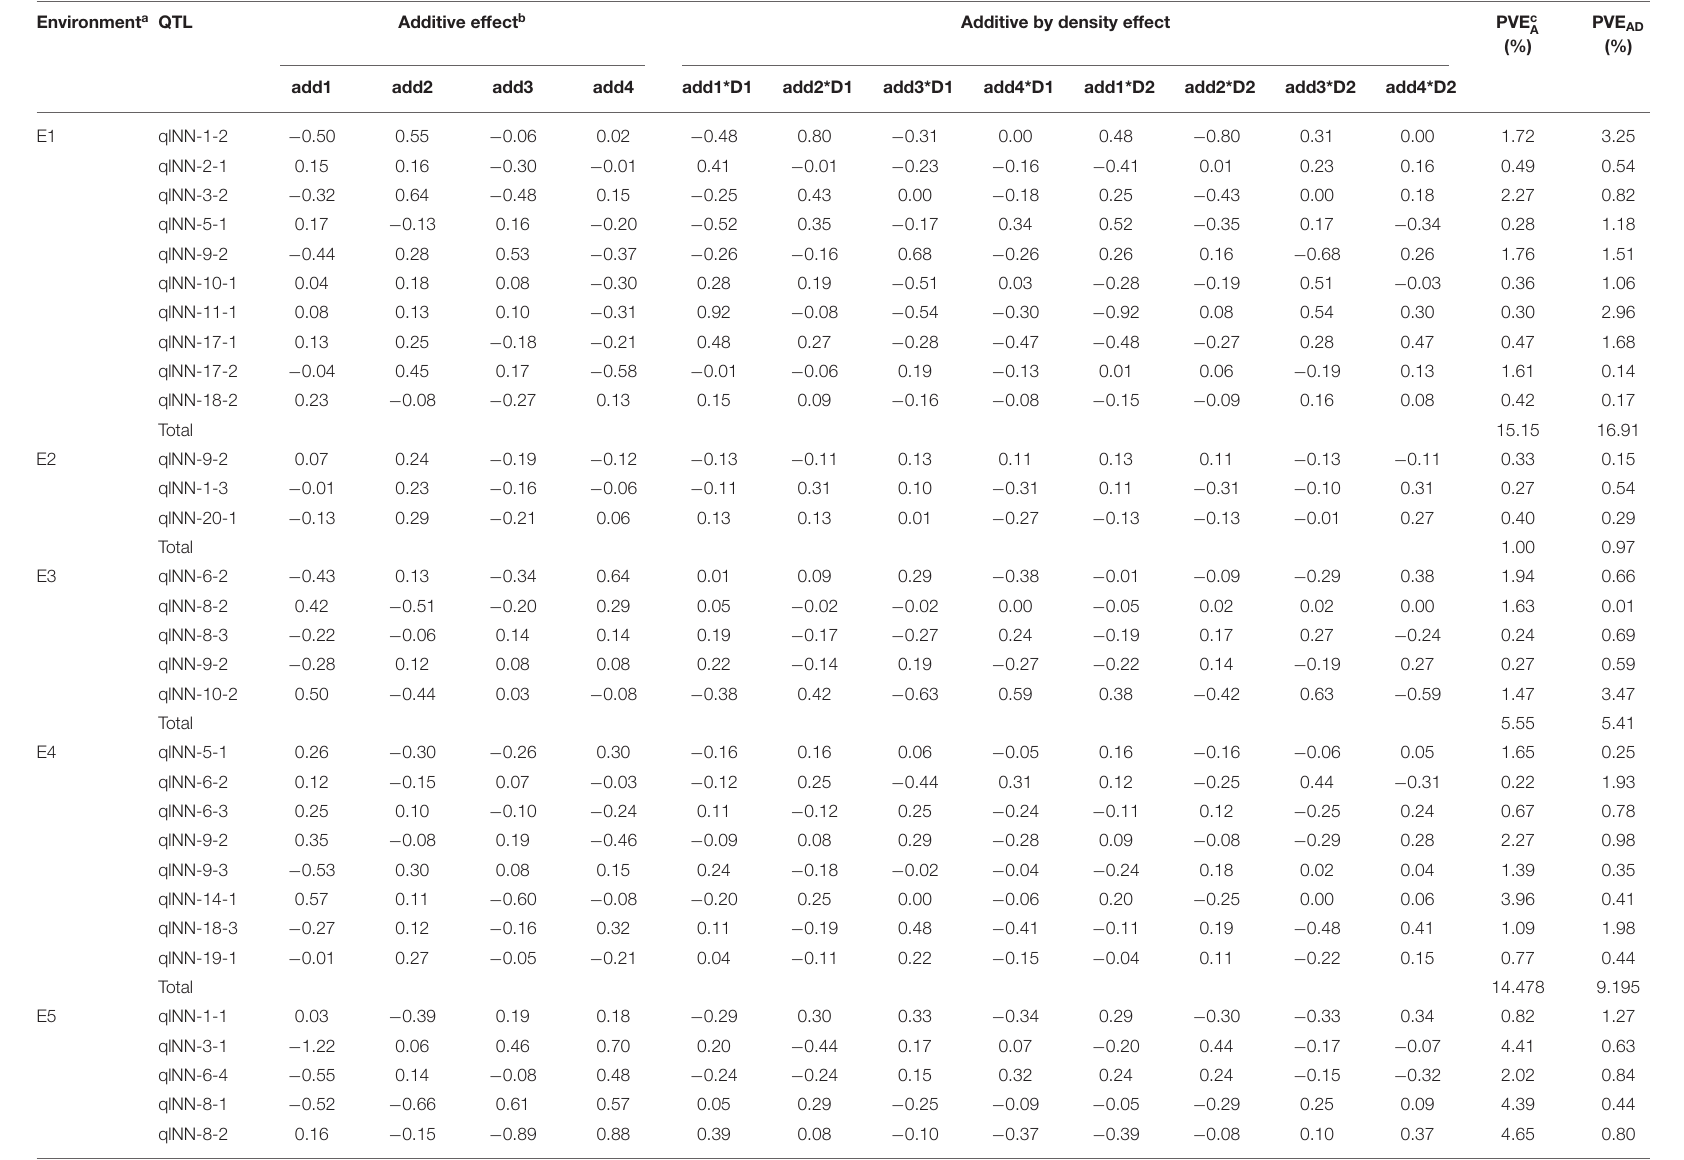
TABLE 4 | Additive and additive by density effect of quantitative trait loci (QTL) under two densities in each